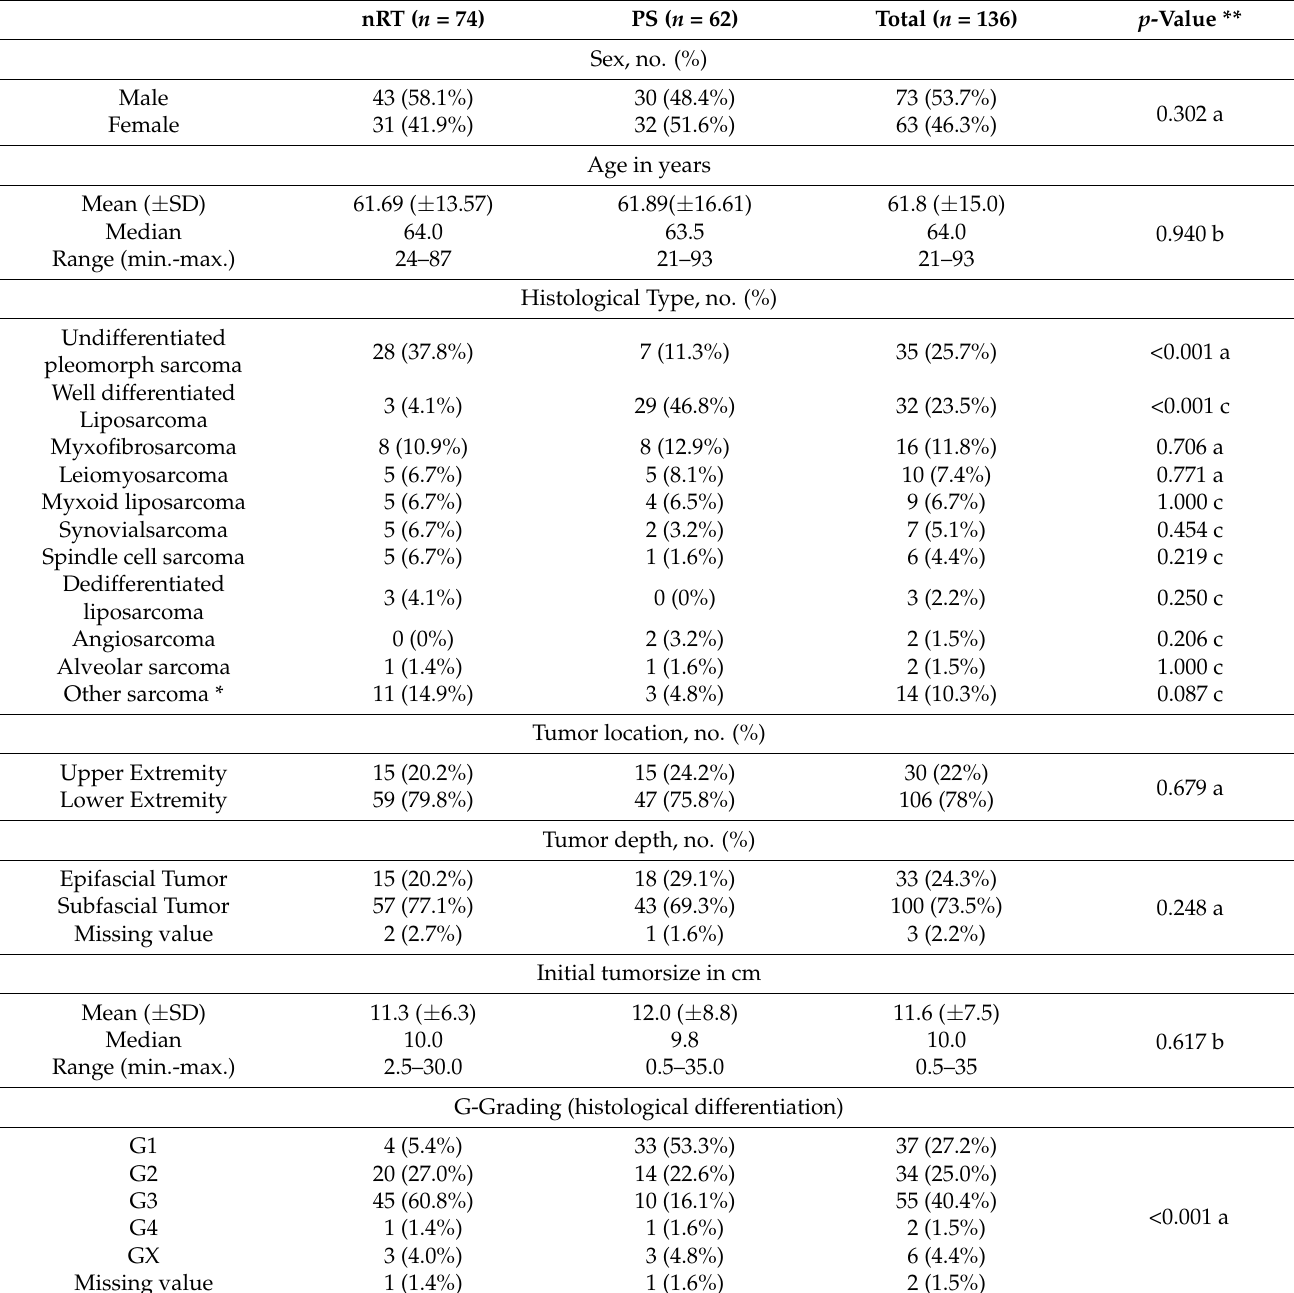
Table 1. Demographic, clinical and histopathological characteristics of patients ( n =